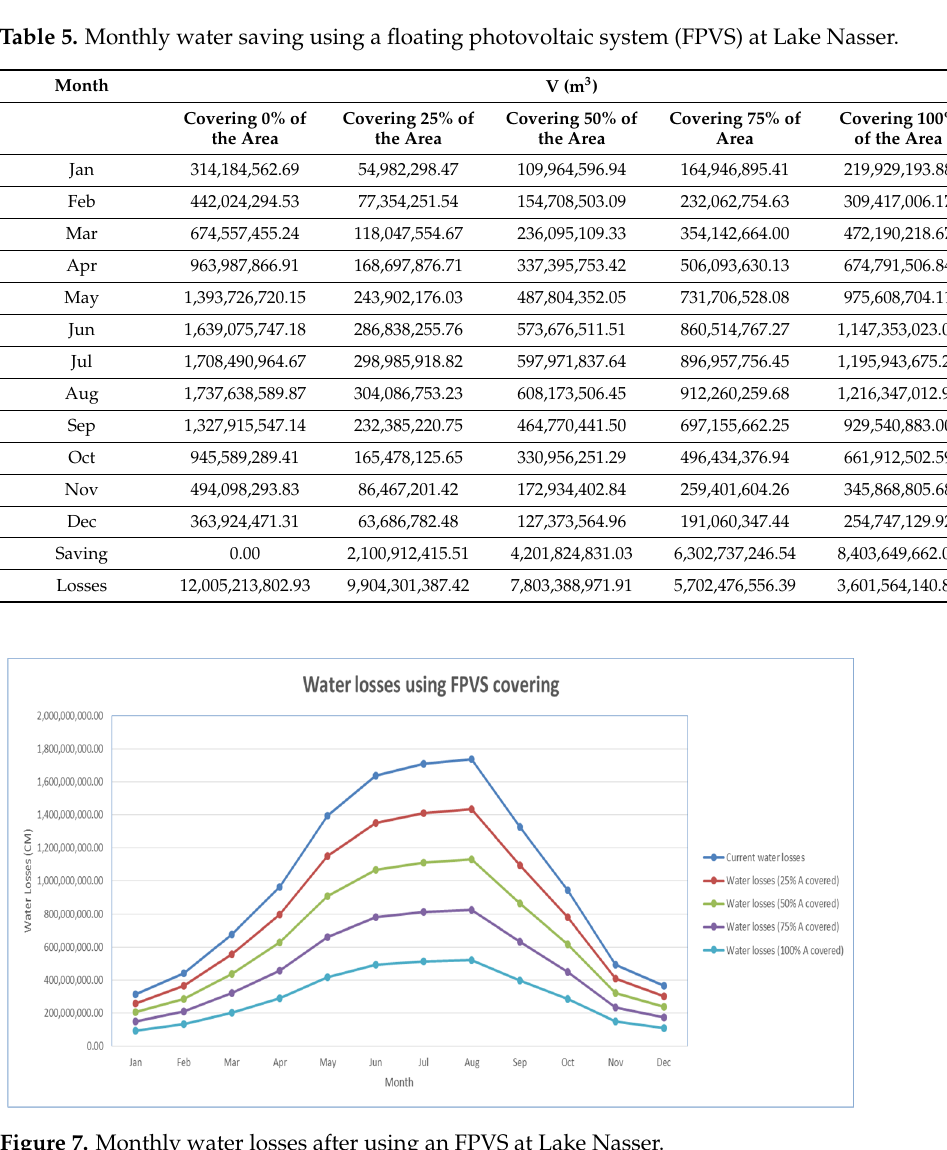
Figure 8. Relation between area covered and water saving at Lake Nasser. 3.3. Energy Production According to the data obtained from the Solar Atlas of Egypt, the available solar power for PV technologies in the study area is 225 W/m 2 . The total surface area of the lake is 5775 km 2 . The energy potential production of the lake was calculated using Equation (8) for the four scenarios (25%, 50%, 75%, and 100% coverage). For the 25%, 50%, 75%, and 100% covered areas, the potential energy production was 2.85, 5.7, 8.55, and 11.40 × 10 9 MWh/year. Figure 9 shows the relation between the area covered and energy production from Lake Nasser.